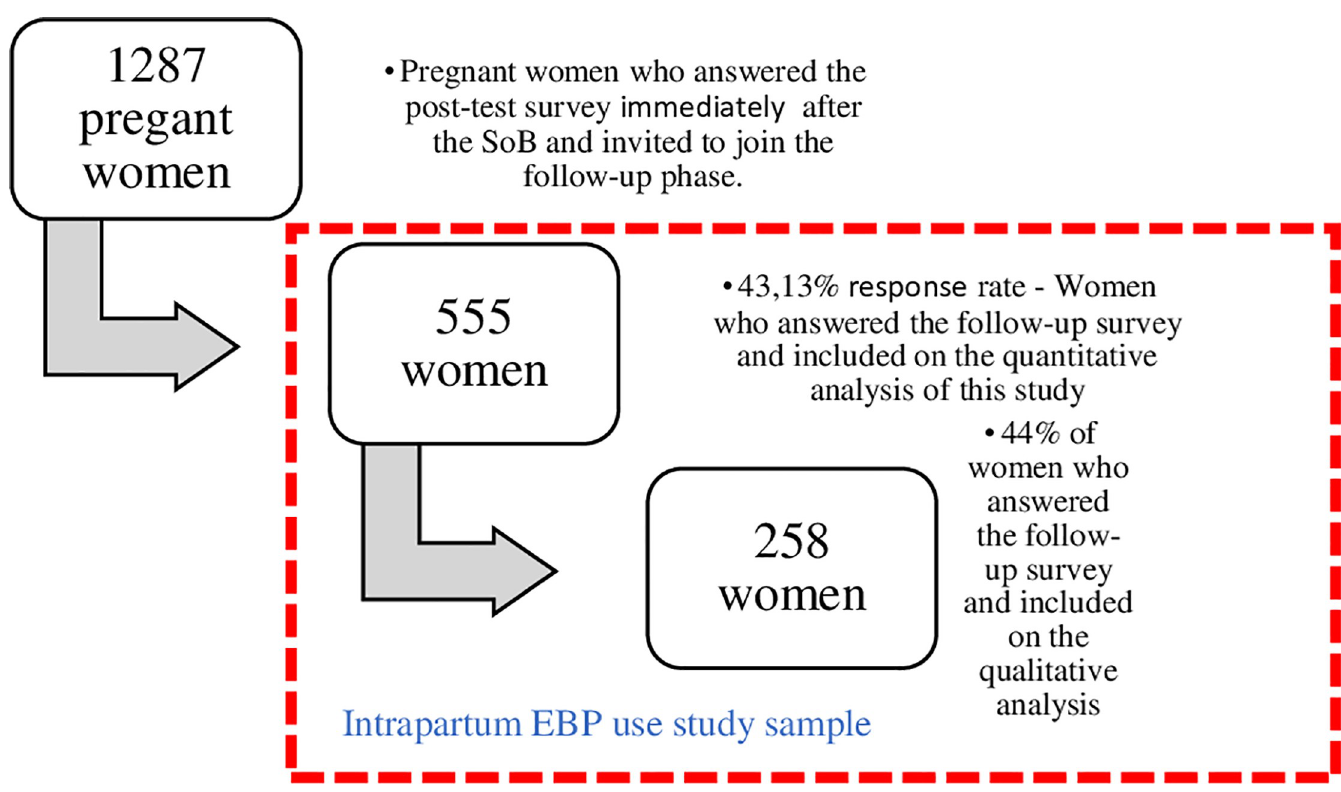
Fig 1. Data collection timeline and sample of women who joined the Senses of Birth intervention and answered the follow-up survey.